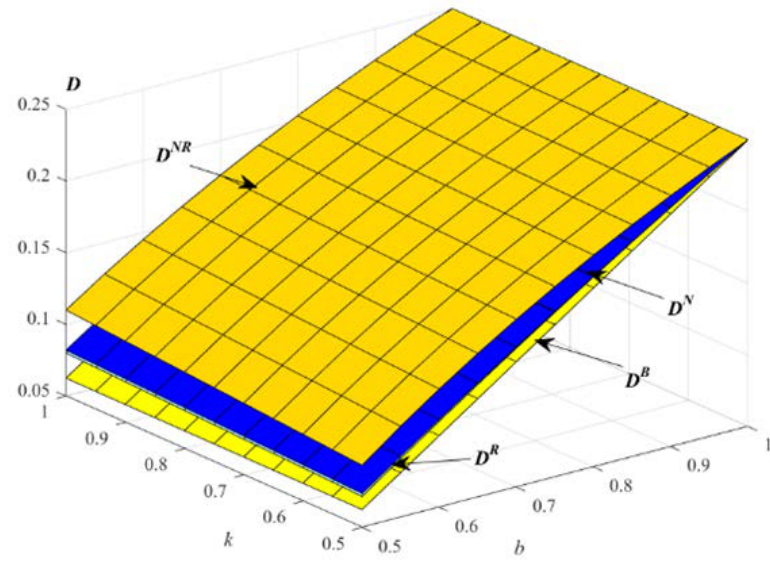
Figure 4. Impact of k and b on the optimal total demand.